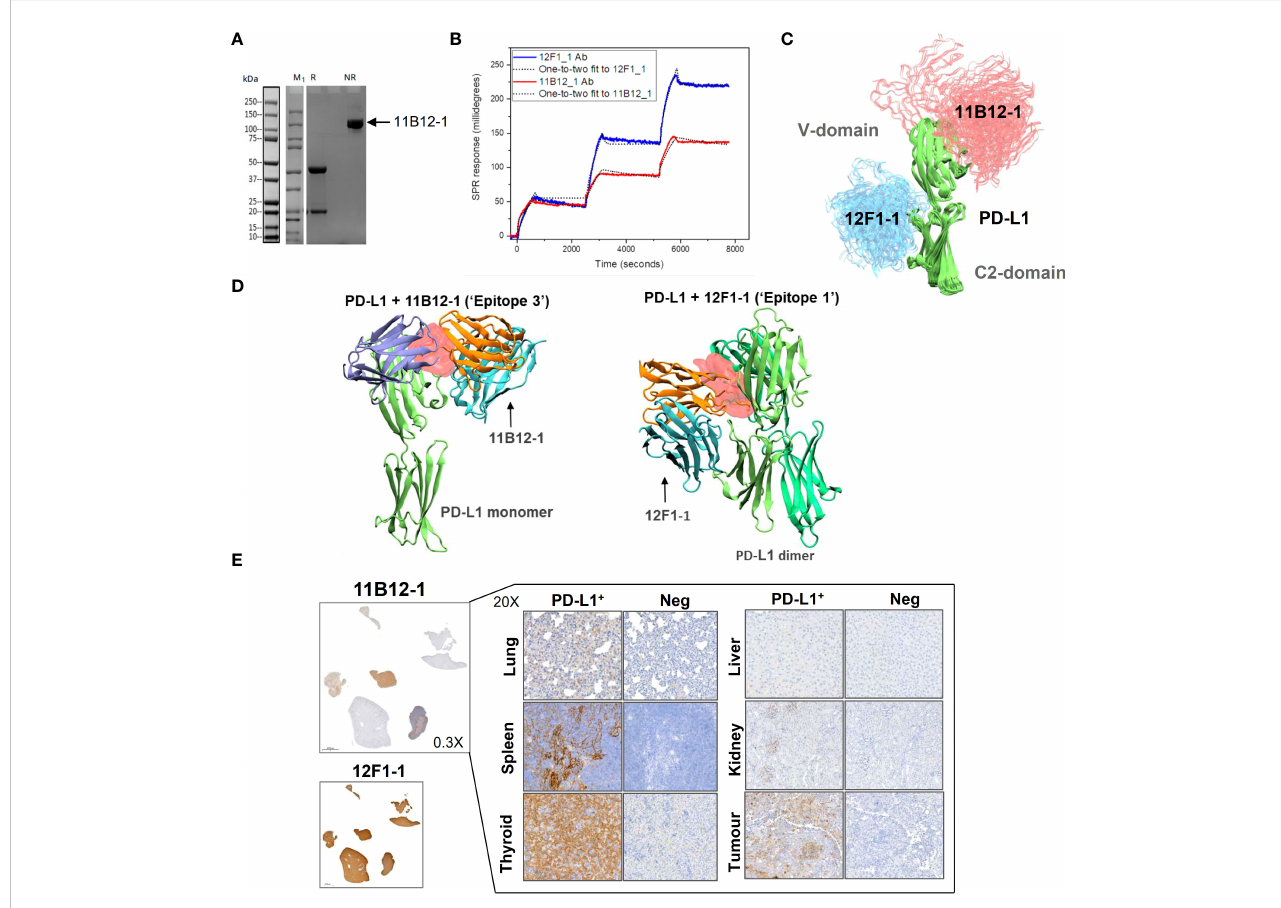
FIGURE 4 Analysis of anti-PD-L1 mAb binding characteristics supports 11B12-1 as a therapeutic antibody. (A) Molecular weight analysis of 11B12-1 by SDS-PAGE where M 1 indicates protein ladder, R: reducing conditions and NR: non-reducing conditions. Puri fi ed 11B12-1 is indicated by the arrow under non- reducing conditions (~100kDa). (B) Sensorgrams of binding af fi nities of 11B12-1 and 12F1-1 with PD-L1 analyzed by surface plasmon resonance binding assay. (C) Snapshots of antibody-antigen complex generated by AF2/ColabFold. For each antibody 20 models from 4 independent runs are overlaid. 11B12-1 is shown in red, 12F1-1 in blue, PD-L1 is depicted in green color. All structures are aligned with respect to PD-L1 coordinates. (D) Upper: 11B12-1